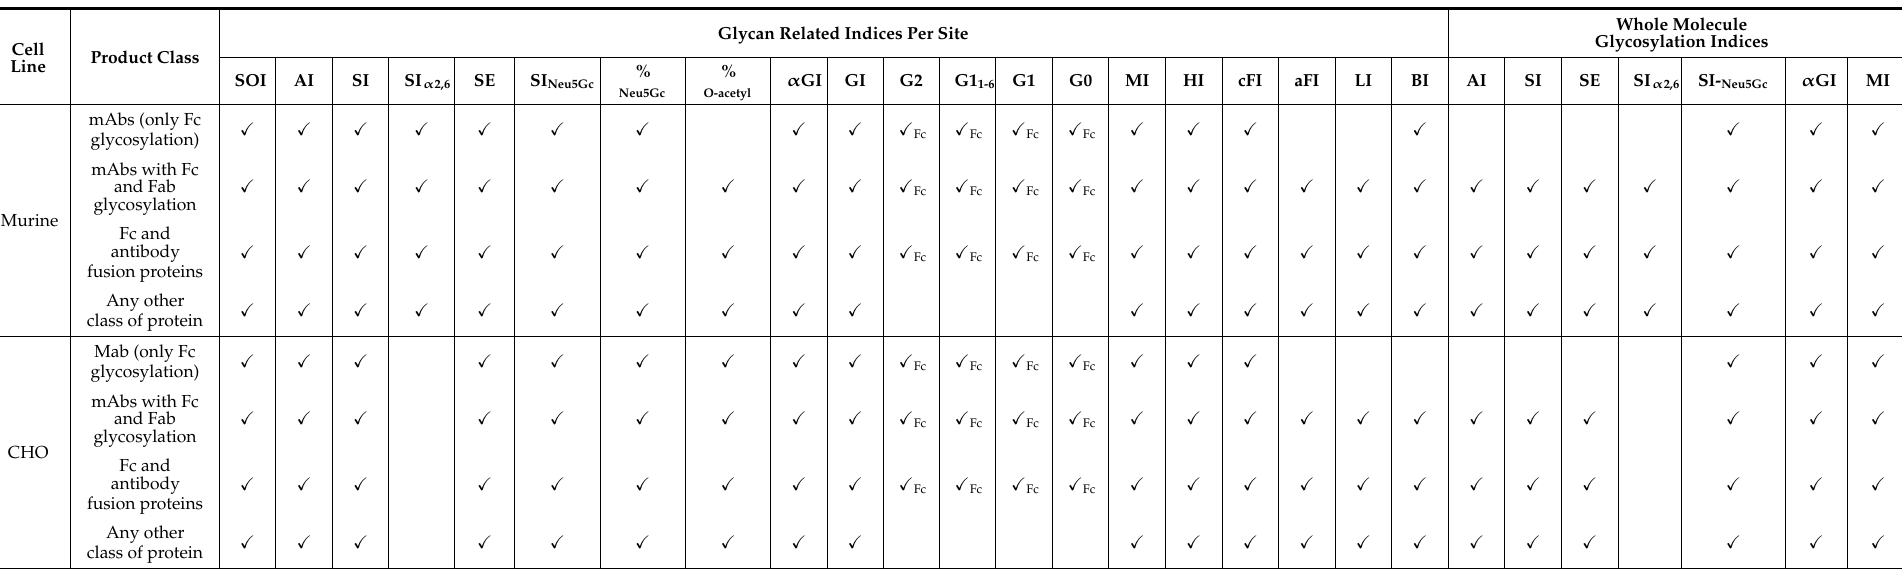
Table 1. Main N-glycan-related indices to be considered at site-specific and whole-molecule level for different classes of biotherapeutics produced by different expression